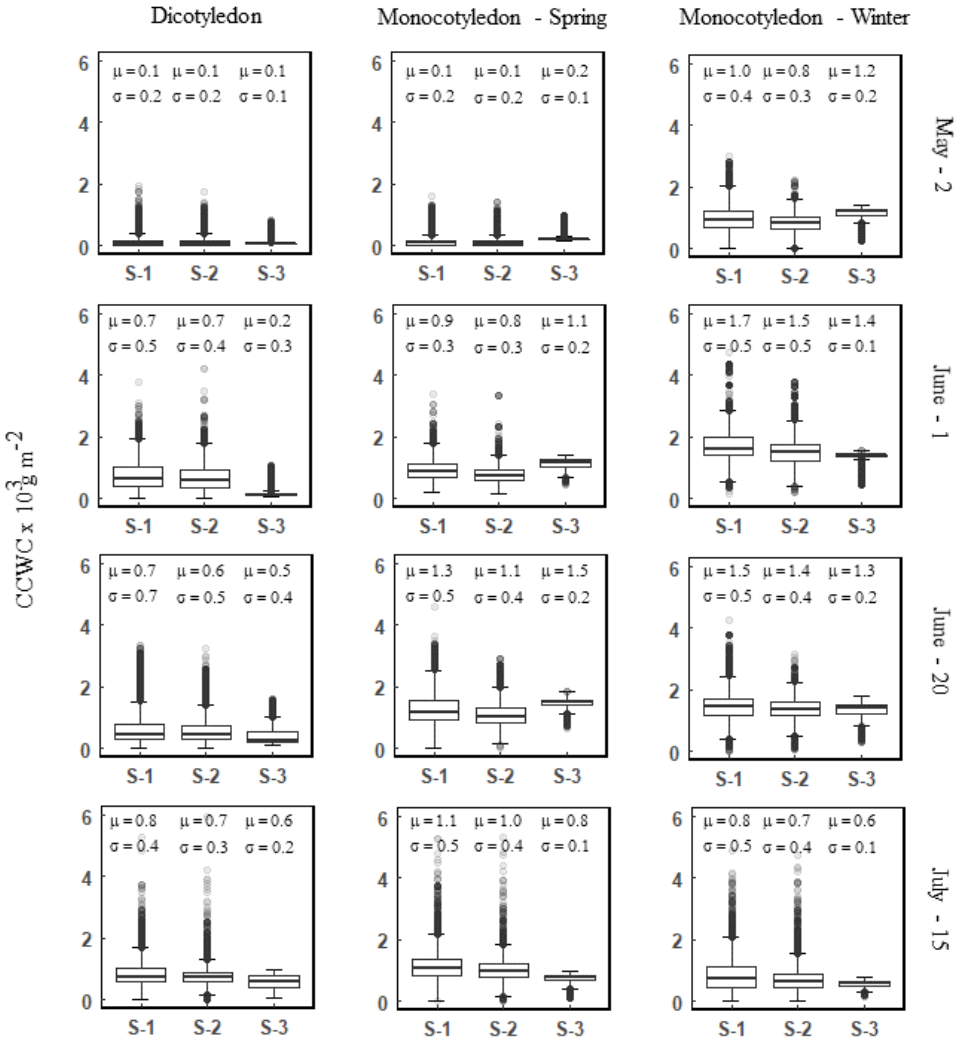
Figure 9. Box plots of the distribution of estimated CCWC in the 8 km × 8 km study area for May 2, June 1, June 20, and July 15 during the 2016 growing season. Results are aggregated into CCWC values for each crop-type: dicotyledon (left column), spring monocotyledon (middle column), and winter monocotyledon (right column). Mean and standard deviations are plotted above each respective box plot for each strategy, labeled S-1, S-2, and S-3 for strategy 1, 2, and 3, respectively.